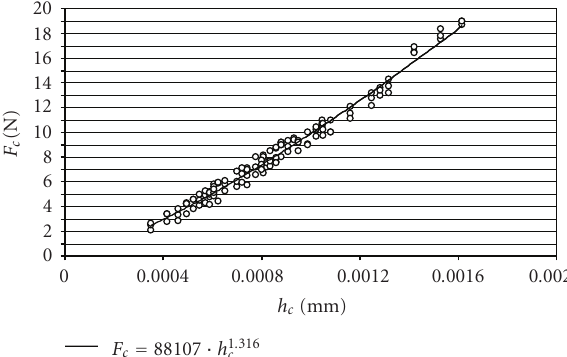
Figure 8: Comparison of model and experimental data of F c